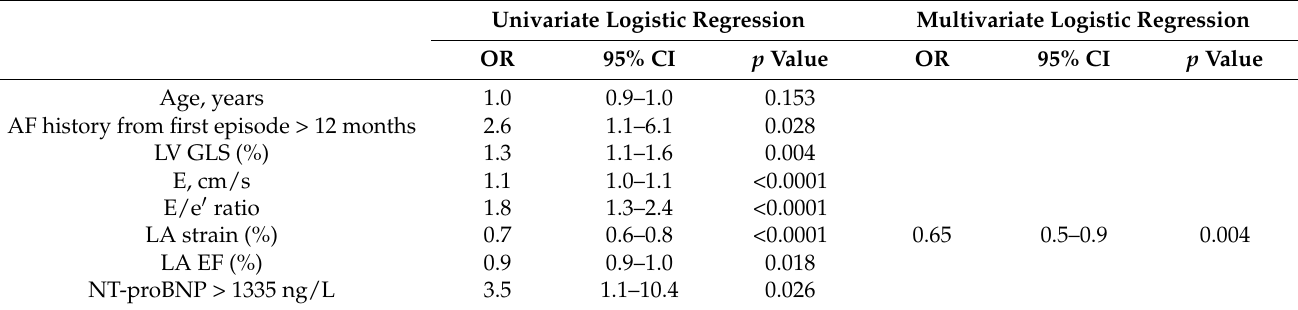
Table 4. Predictors of AF recurrence in the study population.